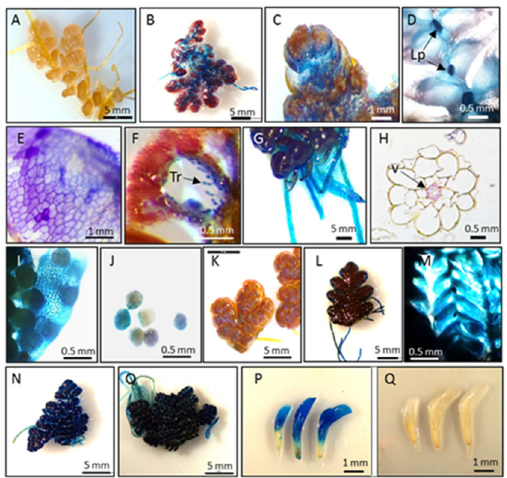
Figure 3. Staining of condensed tannins in A. filiculoides and A. pinnata with 4- dimethylaminocinnamaldehyde (DMACA). A. filiculoides green, non-stained ( A ) and stained by DMACA ( B – J ); leaf ( E ); leaf cavity ( F ); roots ( G – H ); microsporocarps ( I ) microspores ( J ); A. filiculoides red, non-stained ( K ) and stained with DMACA ( L , M ); L. pinnata green, stained ( N ); L. pinnata red, stained ( O ); white clover flowers stained with DMACA (( P ), positive control); white clover flowers not stained with DMACA (( Q ), negative control). Lp: leaf primordia; Tr: trichomes; V: vasculature